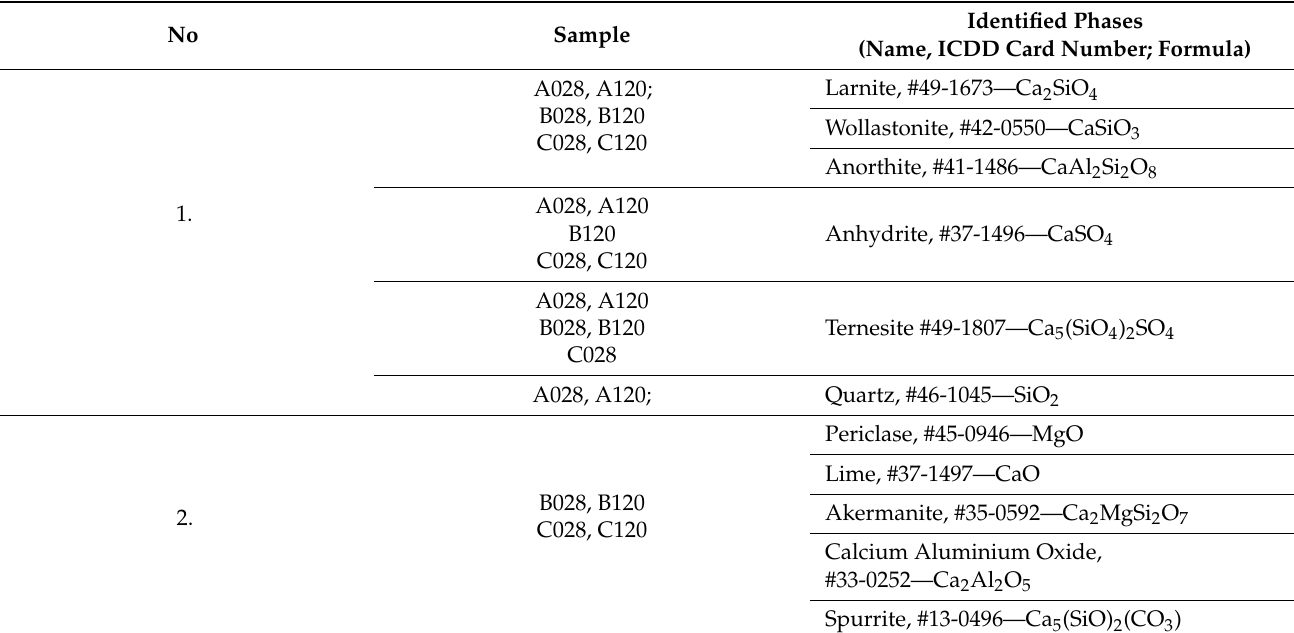
Table 4. Results from PXRD analysis of A028, A120, B028, B120, C028, and C120 after heating up to 1100 ◦